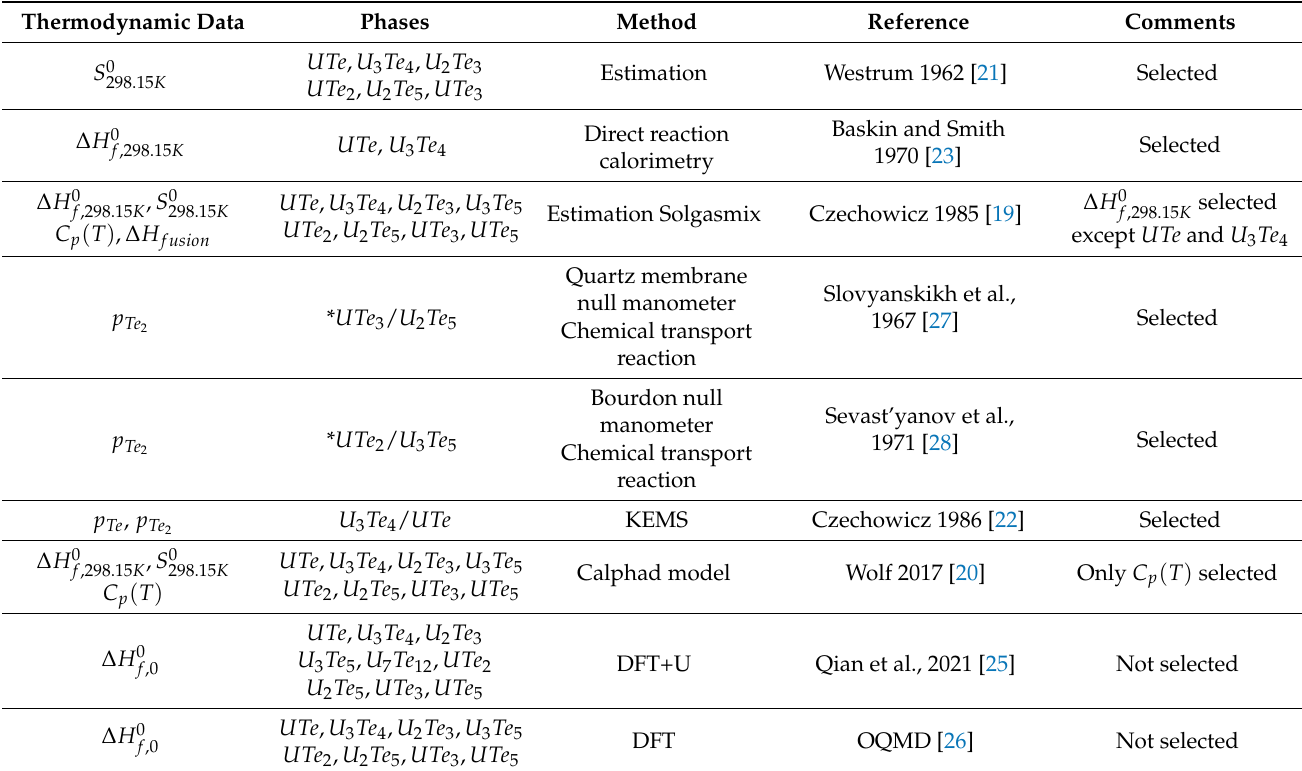
Table 3. Thermodynamic data on the phases of the U–Te system. *: the condensed phases were not characterized. The reported phases by Czechowicz 1986 [22] were proposed on the basis of the phase diagram. The method DFT+U refers to the density functional theory + Hubbard